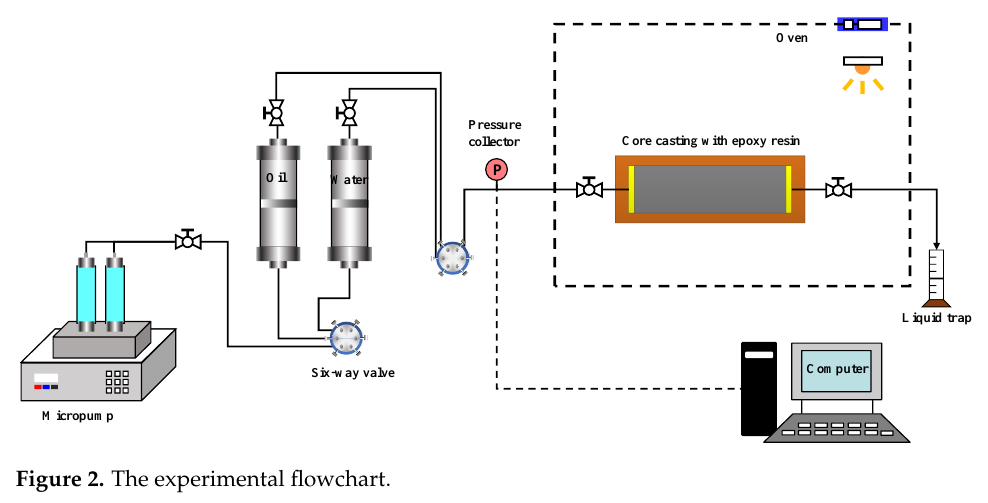
Figure 2. The experimental flowchart.